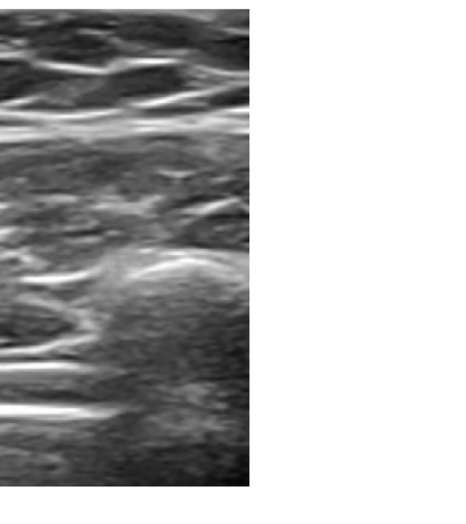
Fig 2. Ultrasonography of the diaphragm